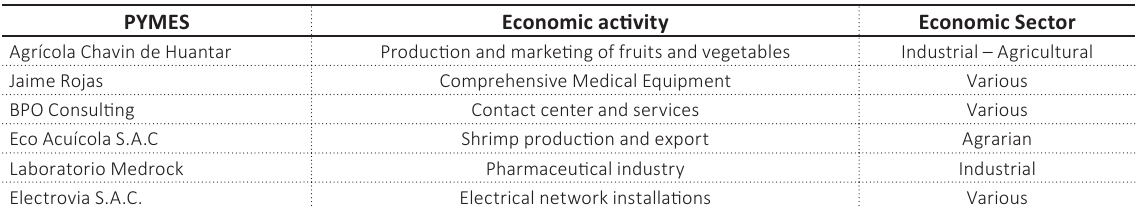
Table 1. Economic characteristics of SMEs financed in the